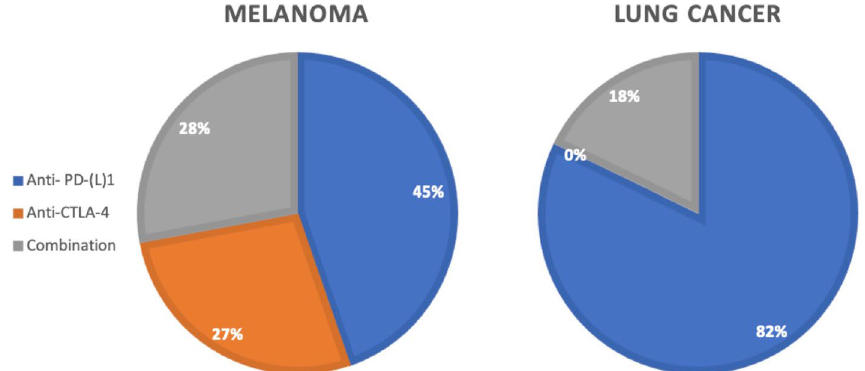
Fig. 3 Use of ICIs related to the primary tumor